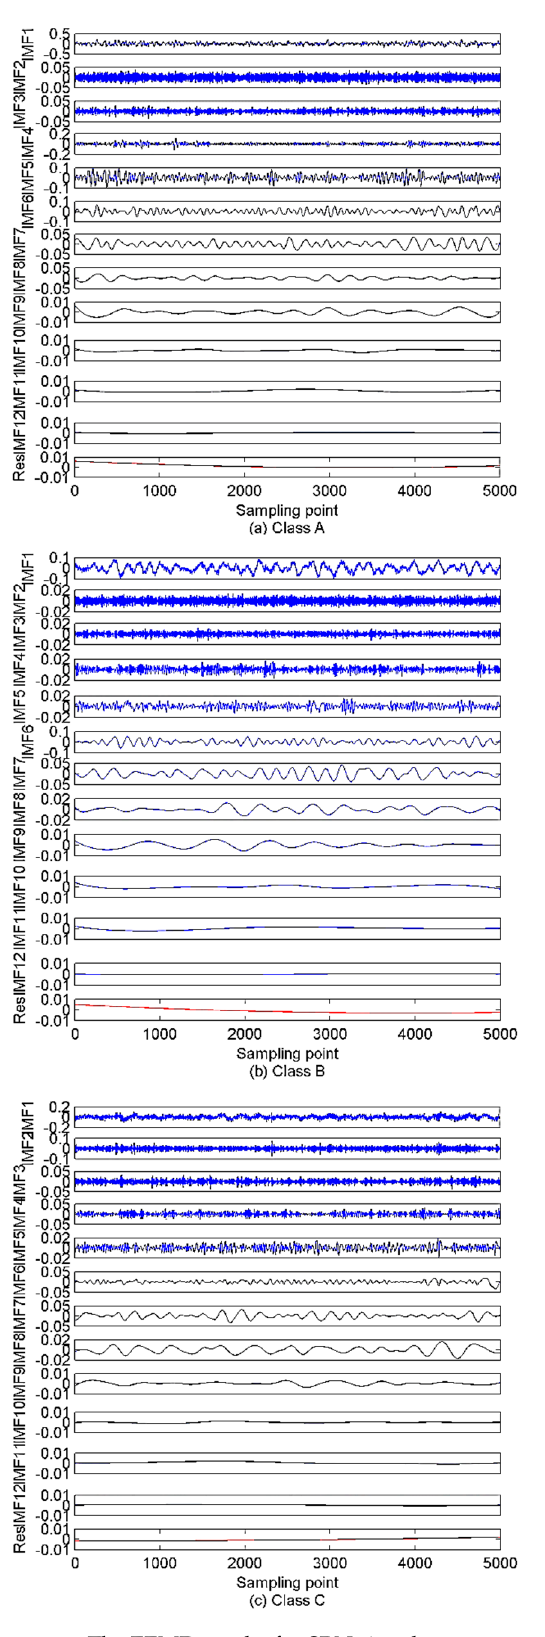
Figure 12. The EEMD results for SRN signals; ( a ) Class A signal; ( b ) Class B signal; ( c ) Class C signal.